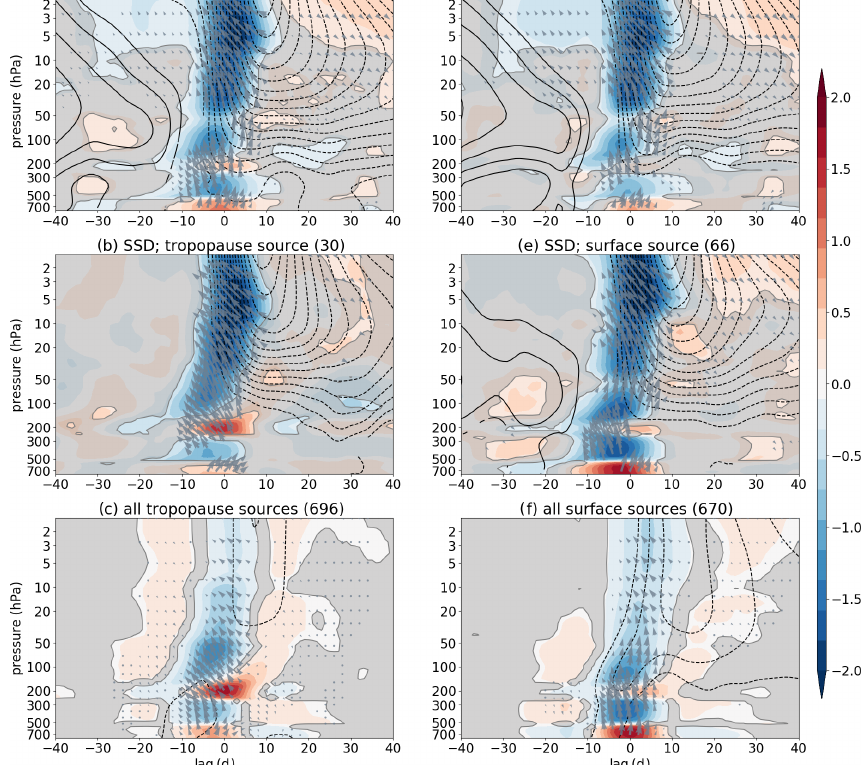
Figure 6. Composite analysis (lag–pressure for data averaged between 40 and 60 ◦ N) showing k = 2 standardized EP flux divergence anoma- lies (shading), k = 2 standardized EP flux anomalies (arrows), and standardized zonal mean zonal wind anomalies (contours; contour interval is 0.1, i.e.,..., − 0 . 15, − 0 . 05, 0.05, 0.15,...). The composites are shown for (a) all SSD events, (b) SSD events preceded by k = 2 tropopause wave source, (c) all k = 2 tropopause wave-source events, (d) SSD events not preceded by k = 2 wave-source events, (e) SSD events preceded by k = 2 lower-tropospheric wave-source events, and (f) all k = 2 lower-tropospheric wave-source events. Panels (a, b, d, e) are centered around SSD events, whereas panels (c, f) are centered around wave-source events. Grey shading masks out data that are not significant at the 95% level. EP fluxes (arrows) and zonal mean zonal wind anomalies (contours) are only shown for values exceeding the 95% significance level. As in Fig. 4, the arrows denote average meridional wave propagation direction (left tilt: equatorward; right tilt: poleward) and its magnification within the chosen latitudinal range at specified pressure and lag (i.e., not propagation in time). Numbers in brackets denote number of events in each composite. Data are from the